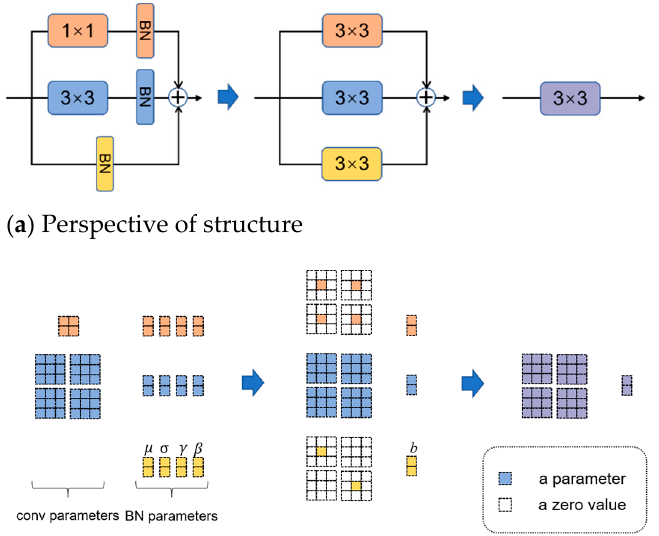
Figure 4. Structural reparameterization of a RepVGG block. ( a ) Structural reparameterization of a RepVGG block from the perspective of structure. ( b ) Structural reparameterization from the perspective of parameter.